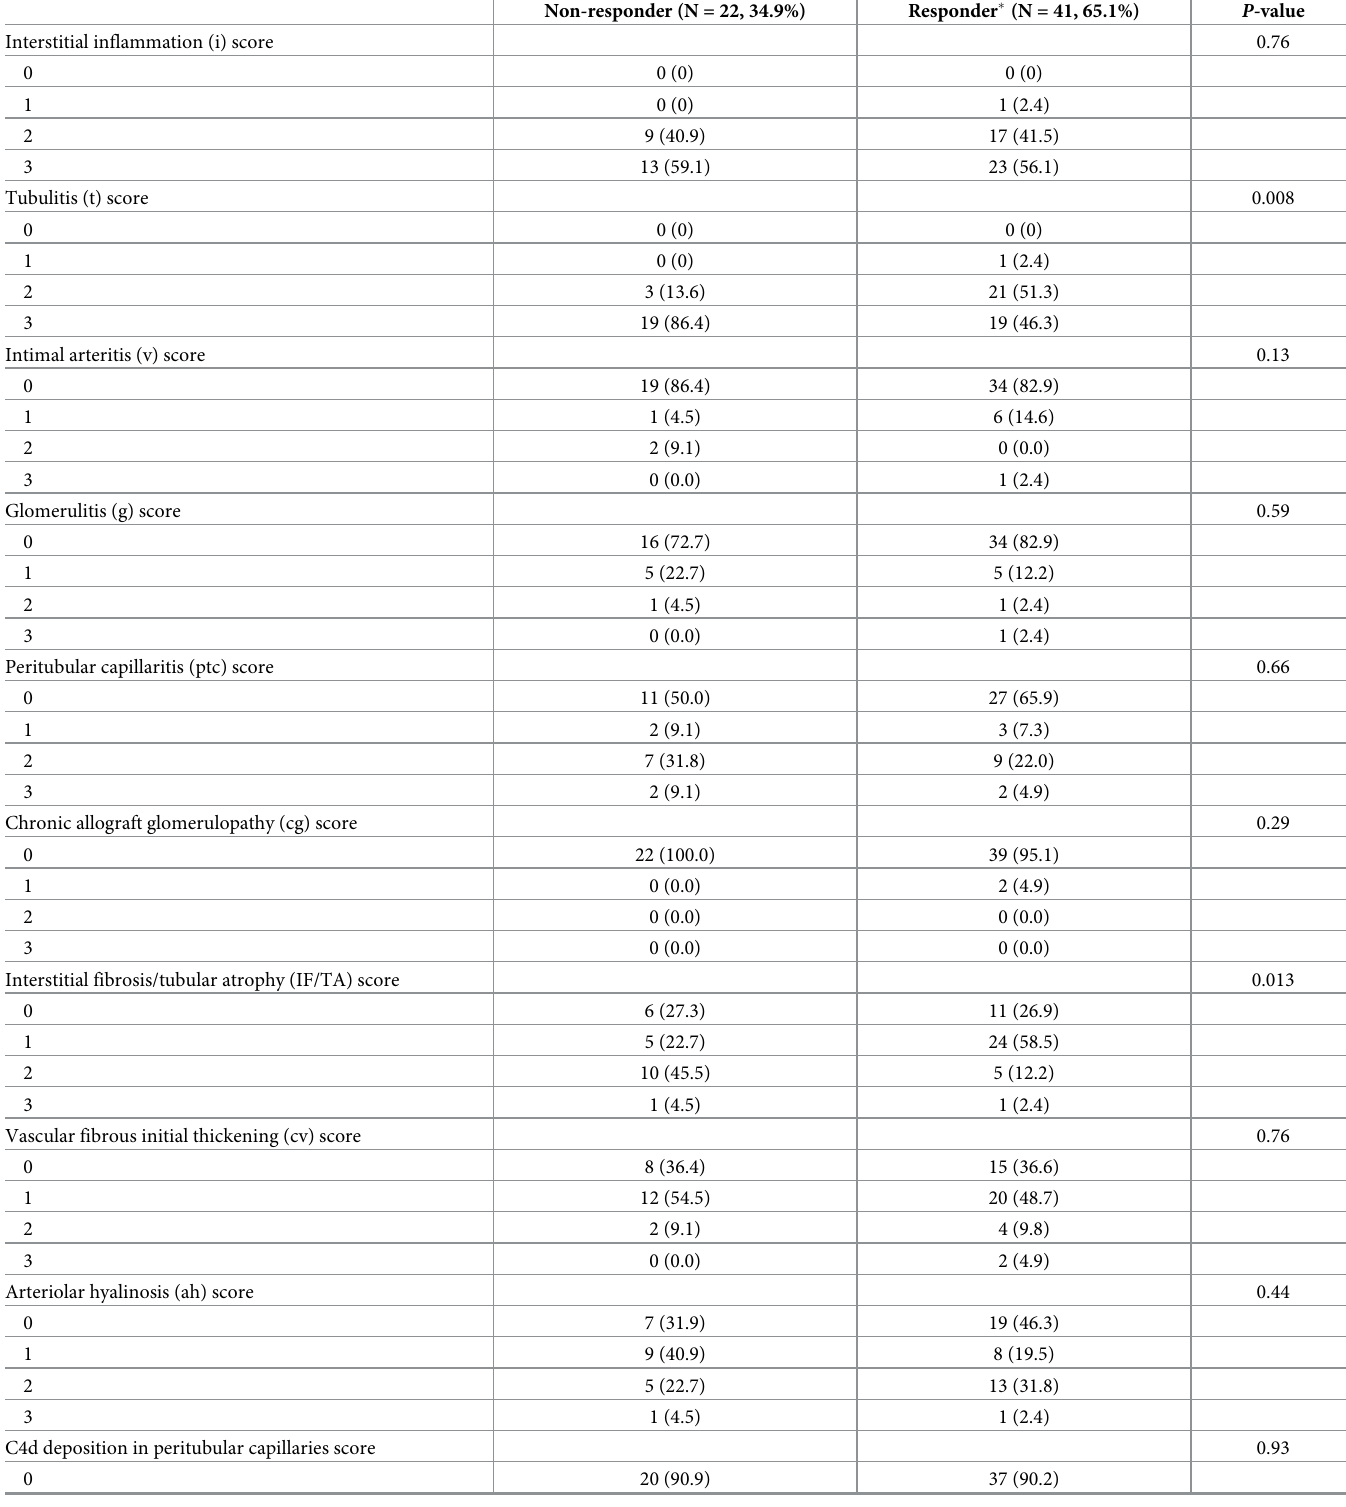
Table 3. Pathologic characteristics at the time of acute T cell-mediated